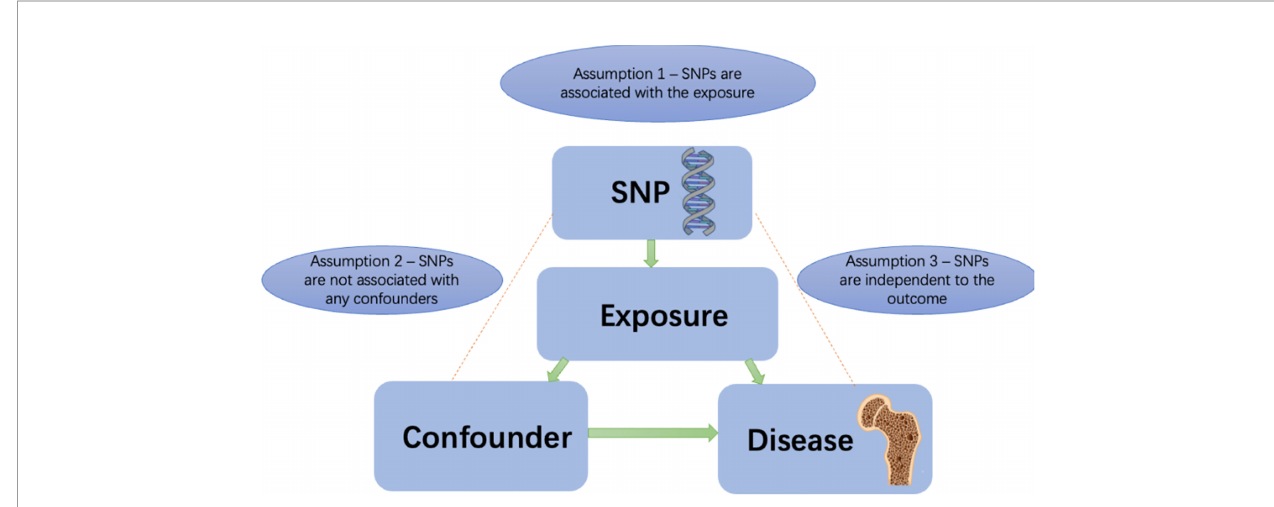
FIGURE 1 | Principles of Mendelian randomization